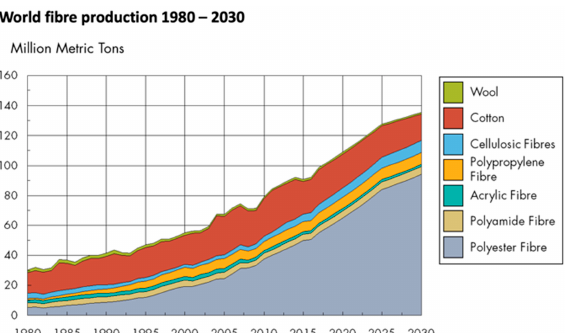
Figure 1. World fiber production for the period 1980–2030, reprinted with permission from Ref. [11].